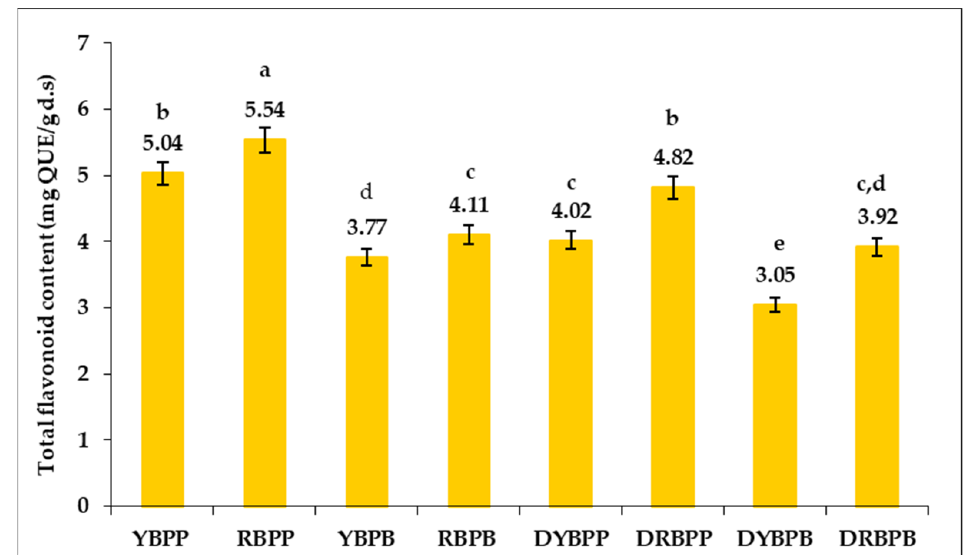
Figure 2. Total flavonoid content (TPC) of yellow and red bell pepper pulp and processing by-products, fresh and after drying. Results are expressed as the mean value of three determinations ± standard deviation (SD) indicated by the error bars. According to the t -test, different letters (a–e) represent significant differences ( p < 0.05) between the values represented in the columns.